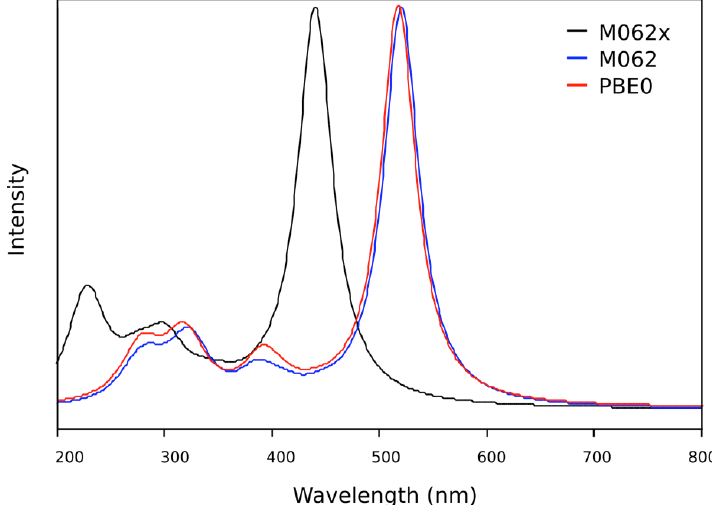
Figure 9. Gaseous state TD-DFT UV/visible spectra of OIC1MS calculated using the M062x functional (black line), M06 functional (blue line) and PBE0 functional (red